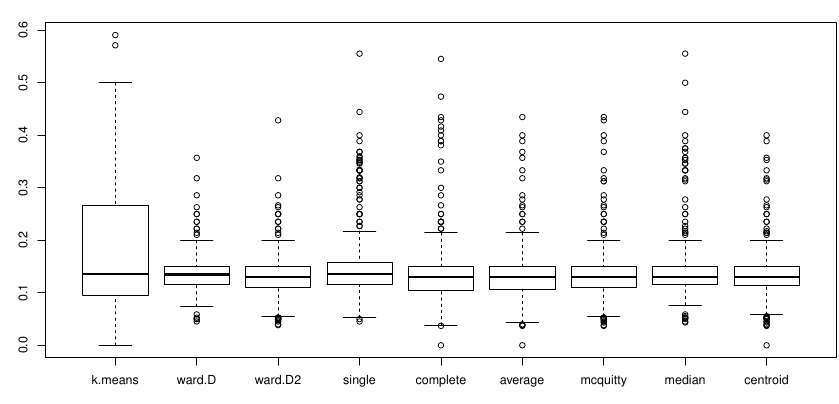
Figure 2. Box plots of simulated MEs using various clustering methods in the second stage of WNACut for γ 1 = 8.